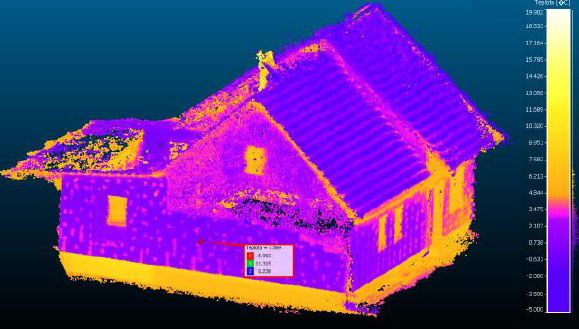
Figure 5. The point cloud where each point is enriched by temperature value.